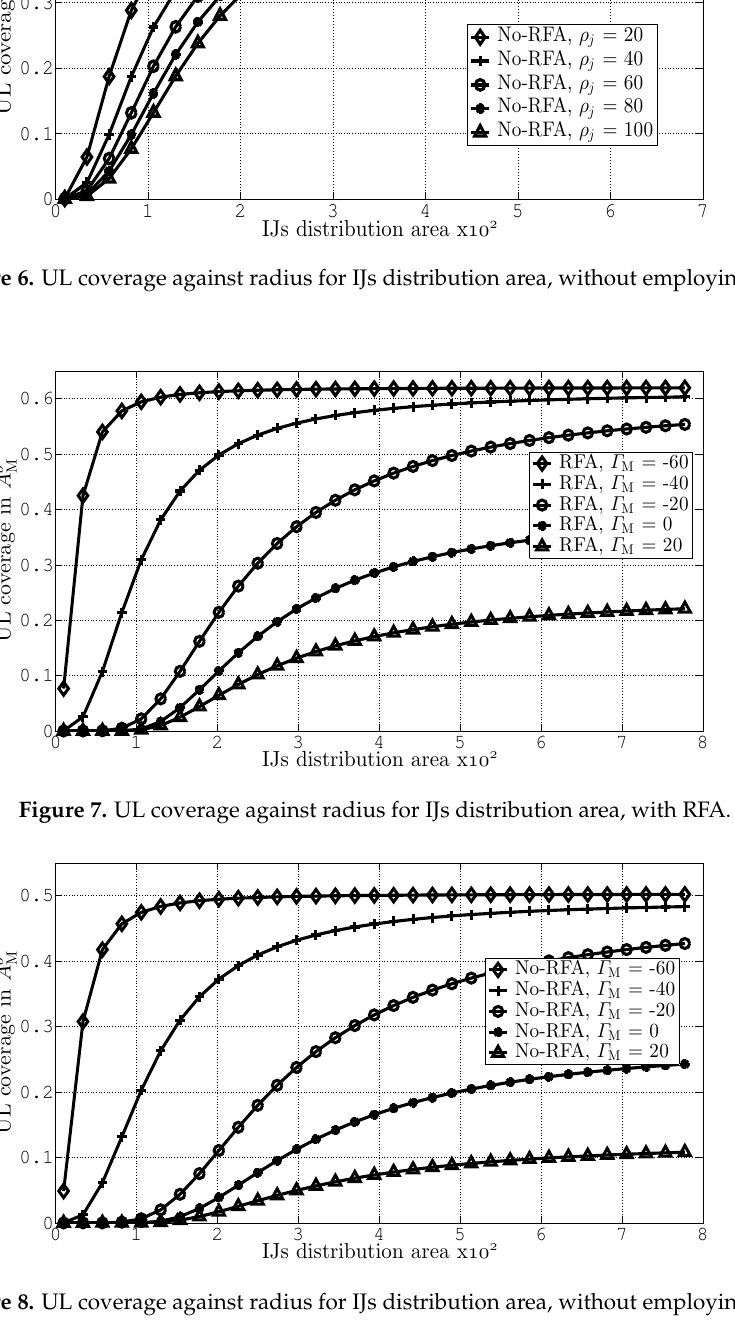
Figure 8. UL coverage against radius for IJs distribution area, without employing